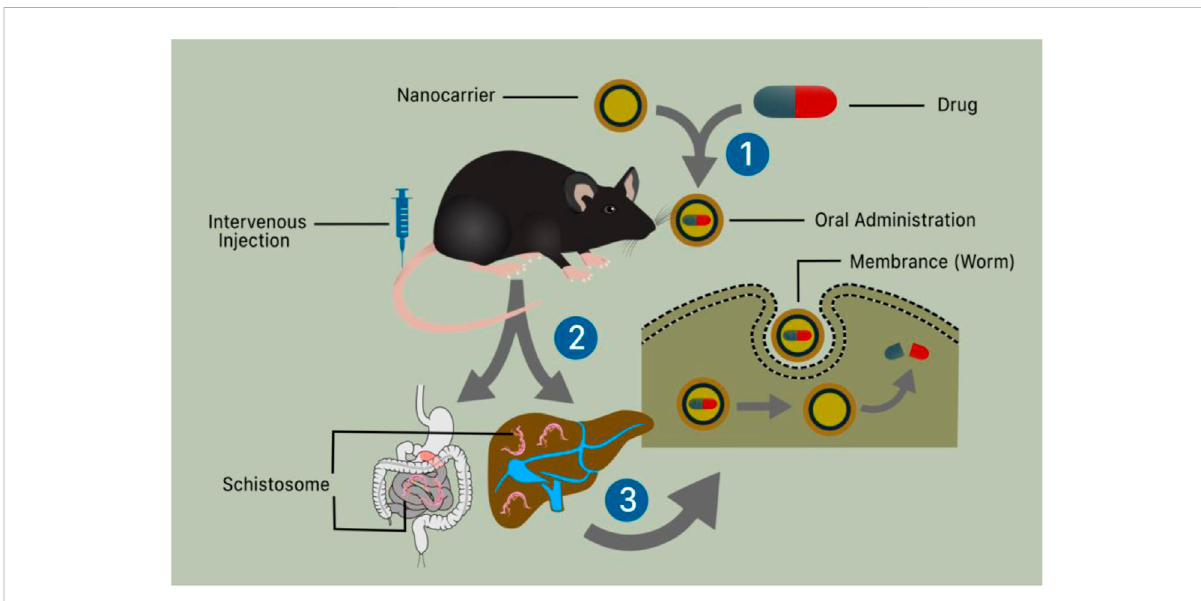
FIGURE 4 Schematic illustration of nanotechnology and nano-enable drug delivery system use in schistosomiasis treatment. (1) The liver and digestive system containing schistosomes that enter the body by skin penetration and reach the speci fi ed organ through the bloodstream (2) The oral and intravenous administration of a nanotechnologically based medication causes the worms ’ membrane (tegument) to rupture, permitting the drug to be distributed and kill the